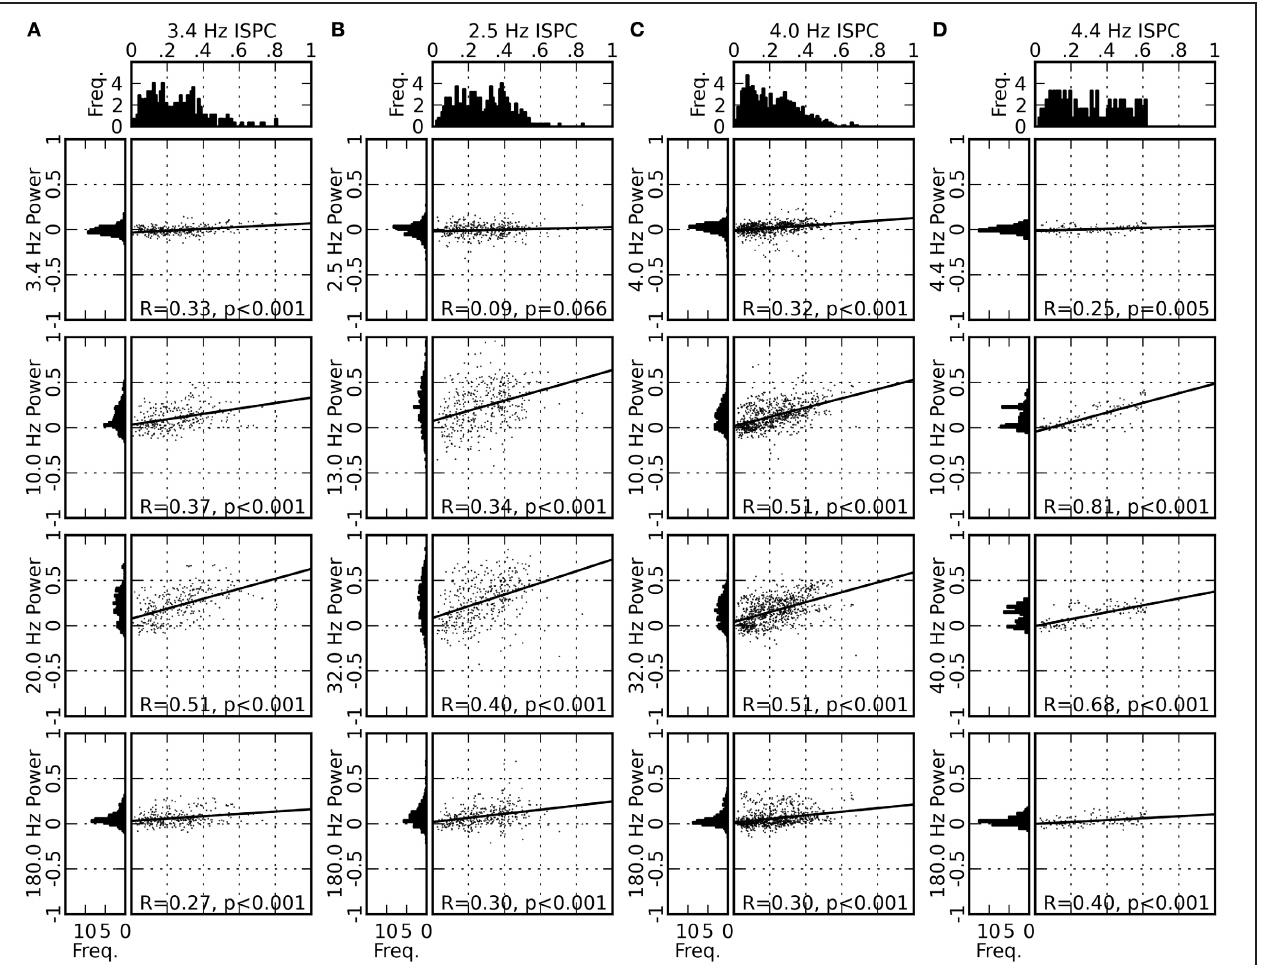
band, respectively, obtained from the data from one recording site in one of the experimental sessions. Results from all recording sites in all experimental sessions are plotted altogether. The solid line represents the linear regression of the data points, with its correlation coefficient ( R -value) and the p -value marked at the bottom (see “Materials and Methods” for methodological details). Panels (A–D) represent the results for monkeys D, S, M, and G,